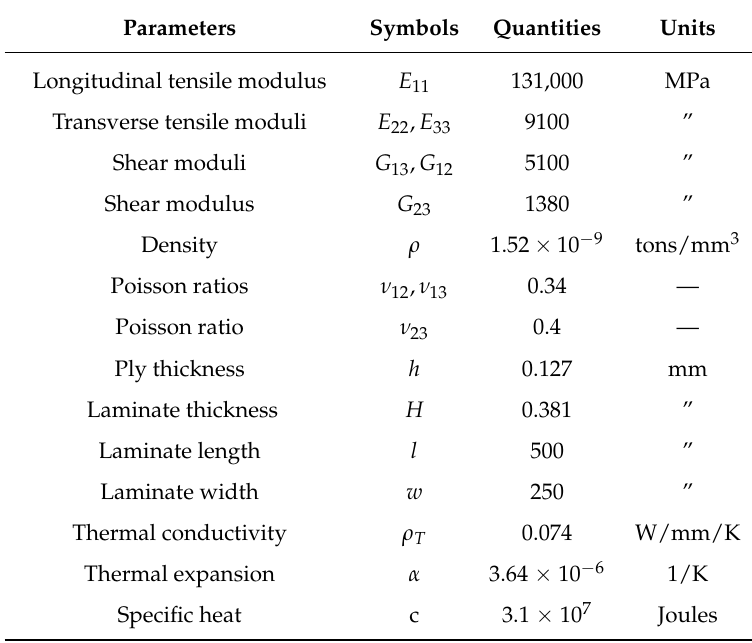
Table 1. Properties of the fiber reinforced composite